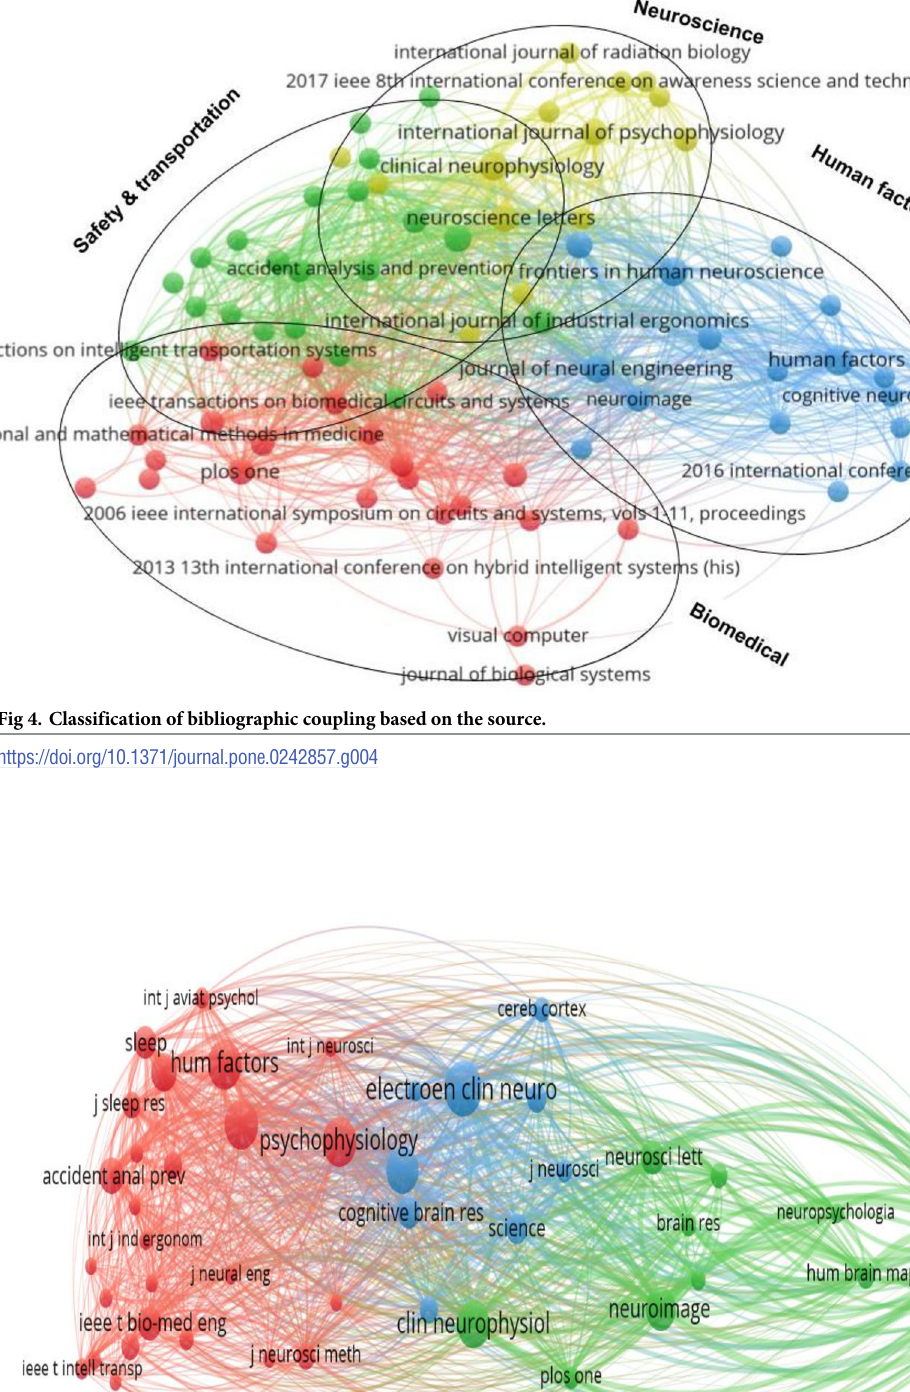
PLOS ONE | https://doi.org/10.1371/journal.pone.0242857 December4,